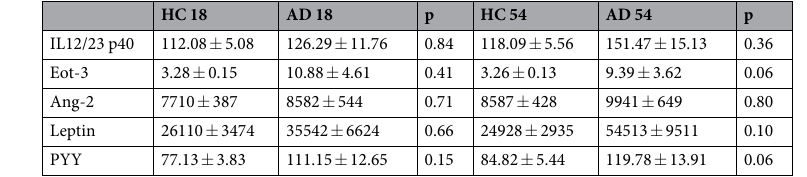
Table 6. General Linear Model analysis of 5 biomarkers in HC and AD at 18 and 54 month time points in APOE ε 4 + in non-converters only. Data are presented as Mean ± S.E., although statistical analysis was performed on the log 10 value to better approximate a normal distribution.